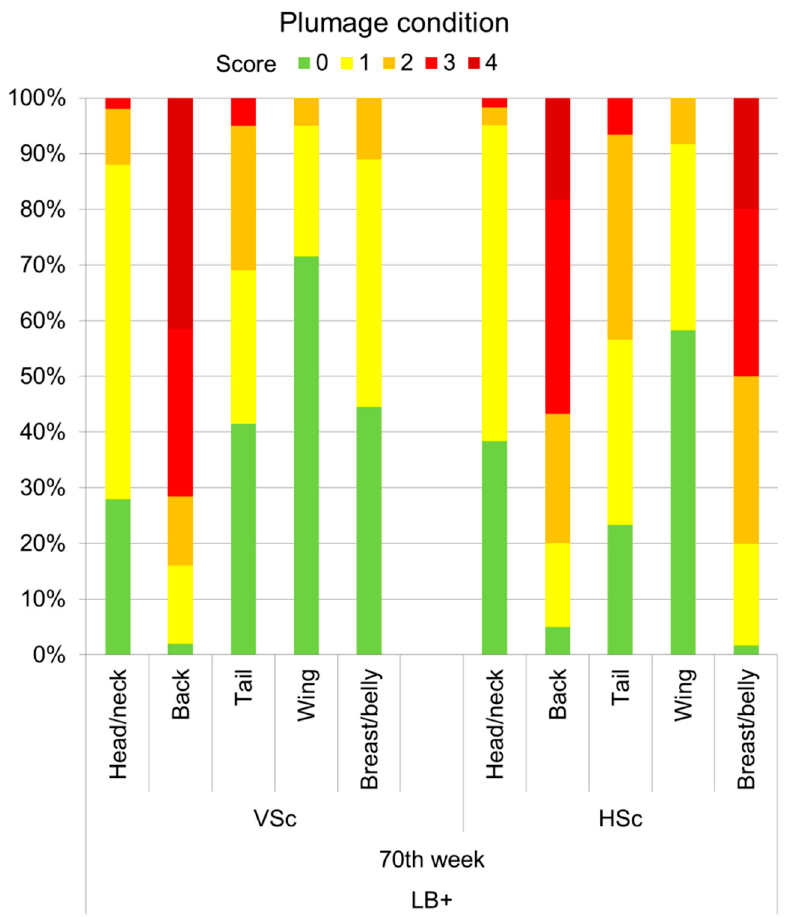
Figure 4. Proportions of LB+ hens with different plumage scores (0 (best) to 4 (worst)) for individual body regions given via VSc ( n = 200 hens) and HSc ( n = 60 hens) scoring methods in the 70th week of life.